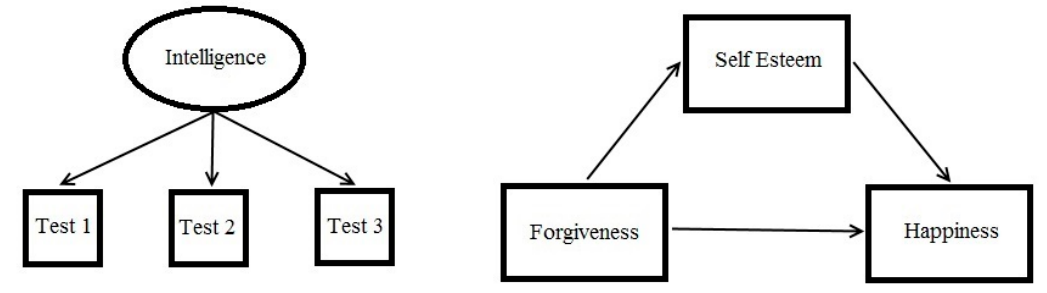
Figure 3. Example path diagrams showing a latent (ellipse) and observable (squares) variables.